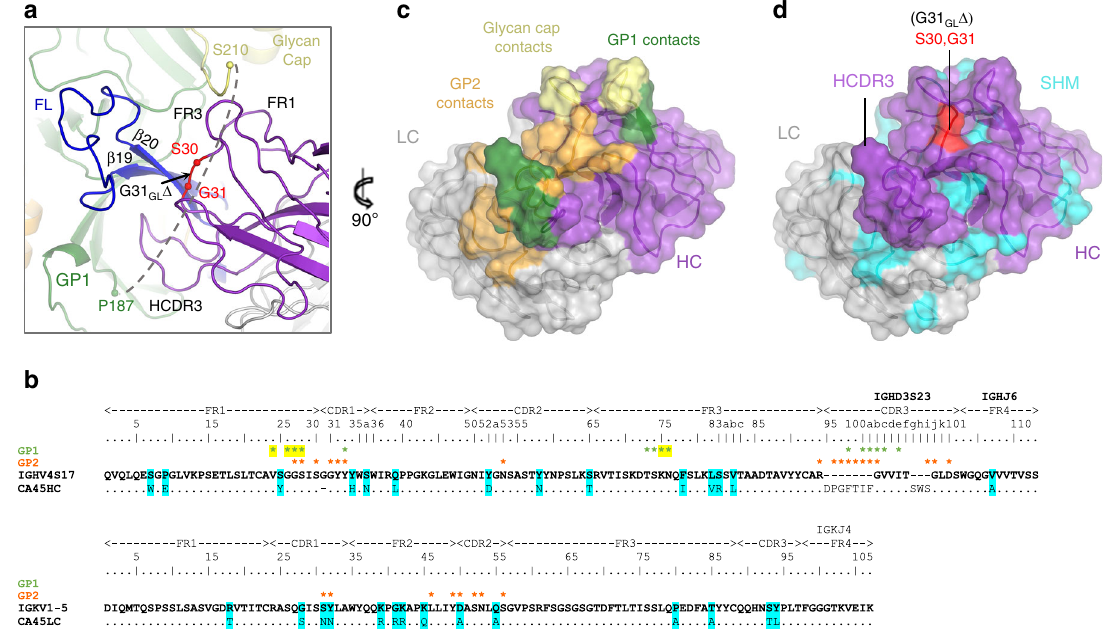
Fig. 6 Somatically matured CA45 bridges the termini of the cathepsin cleavage loop. a A close-up view of CA45 bound to EBOV GP Δ Muc, with C α atoms of residues that fl ank germline deletion G31 GL Δ shown in red spheres. CA45 mediates interactions with both termini (green and yellow spheres) of the disordered cathepsin loop (dashed line). b Sequence alignment of mature CA45 heavy and light chains against cynomolgus macaque germline precursors. Residues that undergo somatic mutation in CA45 are shaded in cyan and those that are buried at the interface with GP1 or GP2 are labeled with green and orange asterisks, respectively. Asterisks shaded yellow mediate interface with glycan cap. c CA45 paratope with full GP interface mapped onto CA45 Fab shown in surface representation (heavy chain, purple; light chain, gray), rotated by 90° from view in a . Footprints of GP1 are shown in green, of glycan cap yellow, and of GP2 orange. d CA45 residues that are somatically hypermutated (SHM) are mapped onto CA45 surface in cyan with unmutated heavy and light chain residues colored in purple and gray, respectively. Shown in same orientation as in c . Residues that fl ank the G31 GL Δ germline deletion are shown in